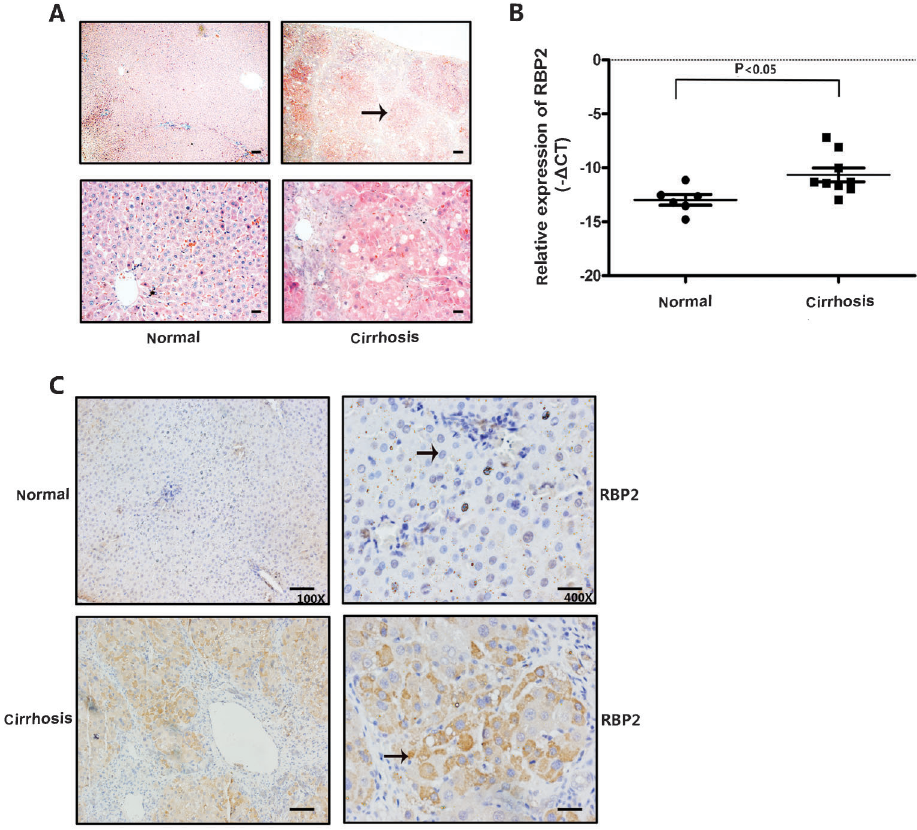
Figure 4. Upregulation of RBP2 in cirrhotic rat livers. A , Hematoxylin and eosin staining of normal and cirrhotic livers. The arrow shows the formed sclerotic nodules in liver. Magnification bar=10 m m. B , RBP2 mRNA expression in normal and cirrhotic livers. Each dot represents 1 rat. The Student t -test was used for analysis. C , RBP2 expression in normal and cirrhotic livers. The arrows show the negative (normal) and positive (cirrhosis) cells. Magnification bars=40 m m (left panels) and 10 m m (right